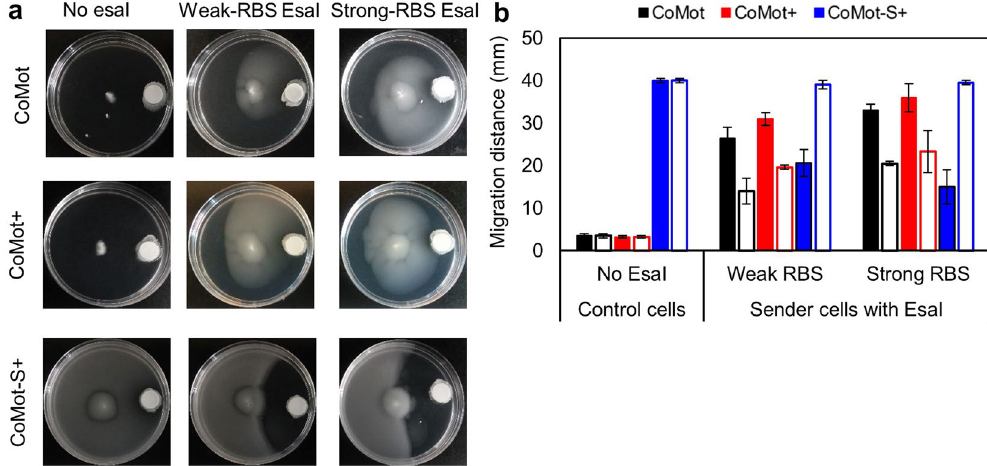
Figure 7. CoMot, CoMot + and CoMot-S + display directional movement in 3OC6HSL gradients generated by sender strains: ( a ) Control cells with no plasmid for EsaI expression, or sender cells where EsaI expression is controlled by a weak or strong RBS were used. Control, weak-sender and strong-sender cells were added on a Whatmann membrane and the plates were incubated for 8 h at 30 °C. CoMot, CoMot + or CoMot-S + were then inoculated at the centre of the plate and incubated at 30 °C for 36 h. Representative plate images are shown. ( b ) Plot of forward (solid bars) and reverse (open bars) migration distances for each sender/receiver combination. Error bars represent one standard deviation from the mean forward migration distance of three biological